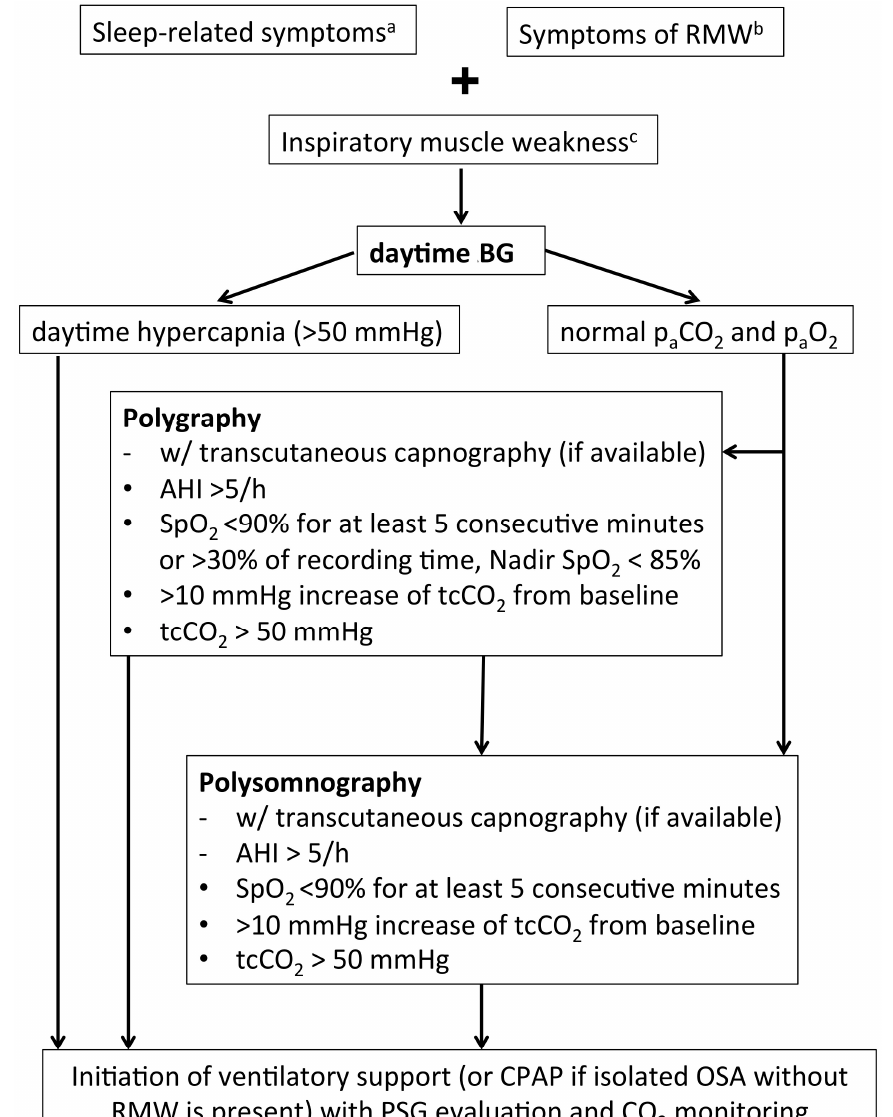
Figure 1. Recommendations for sleep studies in patients with LOPD. Isolated nocturnal tachypnea or lone increase of base excess on early-morning blood gas analysis may both be indicative of nocturnal hypoventilation but do not justify ventilatory support. However, both scenarios should give rise to monitor patients in shorter intervals. a sleep disruption, morning headache, daytime hypersomnolence; b dyspnea, orthopnea; c VC < 50% predicted, VC postural drop > 40%, MIP < 60 cm H 2 O, SNIP < 40 cm H 2 O. VC, vital capacity; RMW, respiratory muscle weakness; paCO 2 , carbon dioxide tension; paO 2 , oxygen tension; AHI, apnea hypopnea index; SpO 2 , oxygen saturation; tcCO 2 , transcutaneous carbon dioxide tension; CPAP, continuous positive airway pressure; OSA, obstructive sleep apnea; PSG, polysomnography; SNIP, sniff nasal inspiratory pressure; MIP maximum inspiratory pressure.